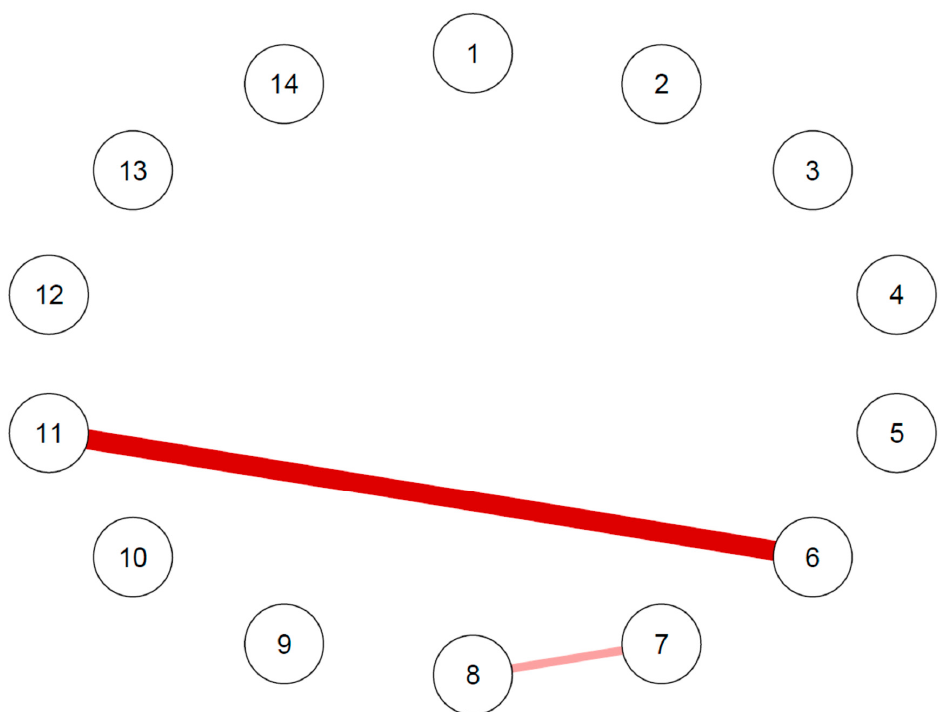
Figure 6. Graphical representation of edge differences in the trait-like features network with Bayesian estimation between those with and without MACE at follow-up. 1: TAS-20 Difficulty identifying feelings; 2: TAS-20 Difficulty describing feelings; 3: TAS-20 Externally oriented thinking; 4: TCI Novelty-seeking; 5: TCI Harm avoidance; 6: TCI Reward dependence; 7: TCI Self-directedness; 8: TCI Cooperativeness; 9: TCI Self-transcendence; 10: DS-14 Negative affectivity; 11: DS-14 Social inhibition; 12: DSQ-40 Mature defenses; 13: DSQ-40 Neurotic defenses; 14: DSQ-40 Immature defenses. Each node corresponds to a trait-like feature. The edges connecting the nodes indicate the main edge differences between the network of those with MACE and those without MACE. All edges are red, indicating negative differences.